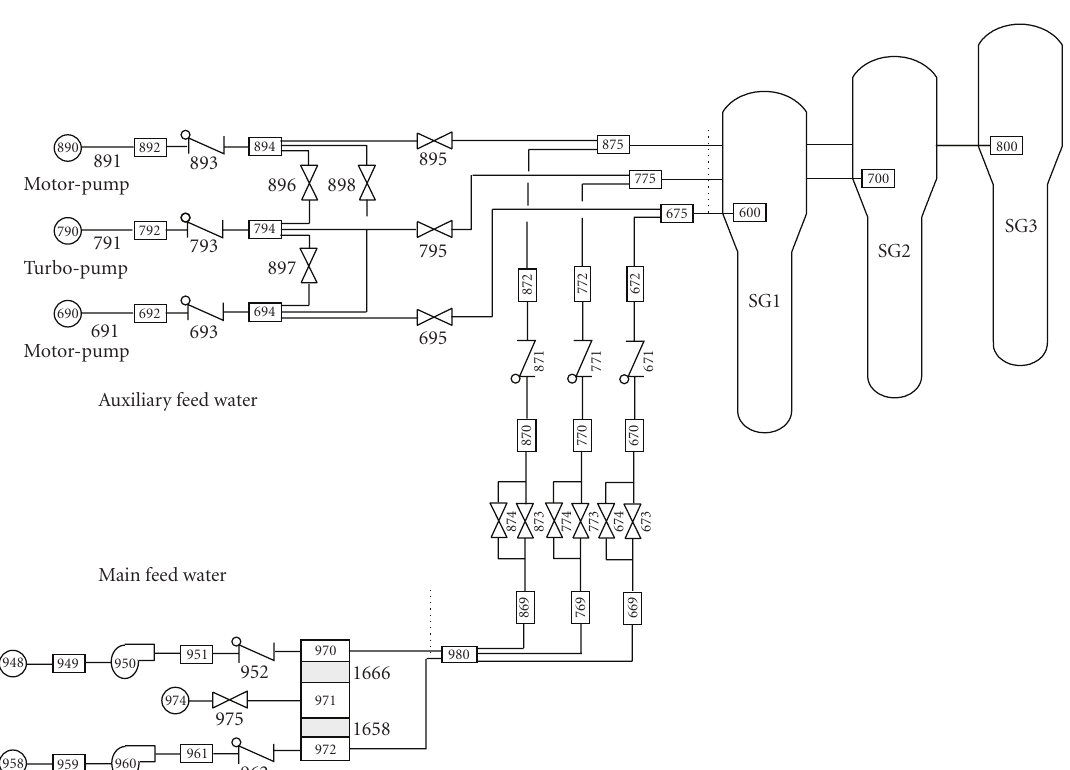
Figure 2: Nodalization diagram of the Asc´o FW